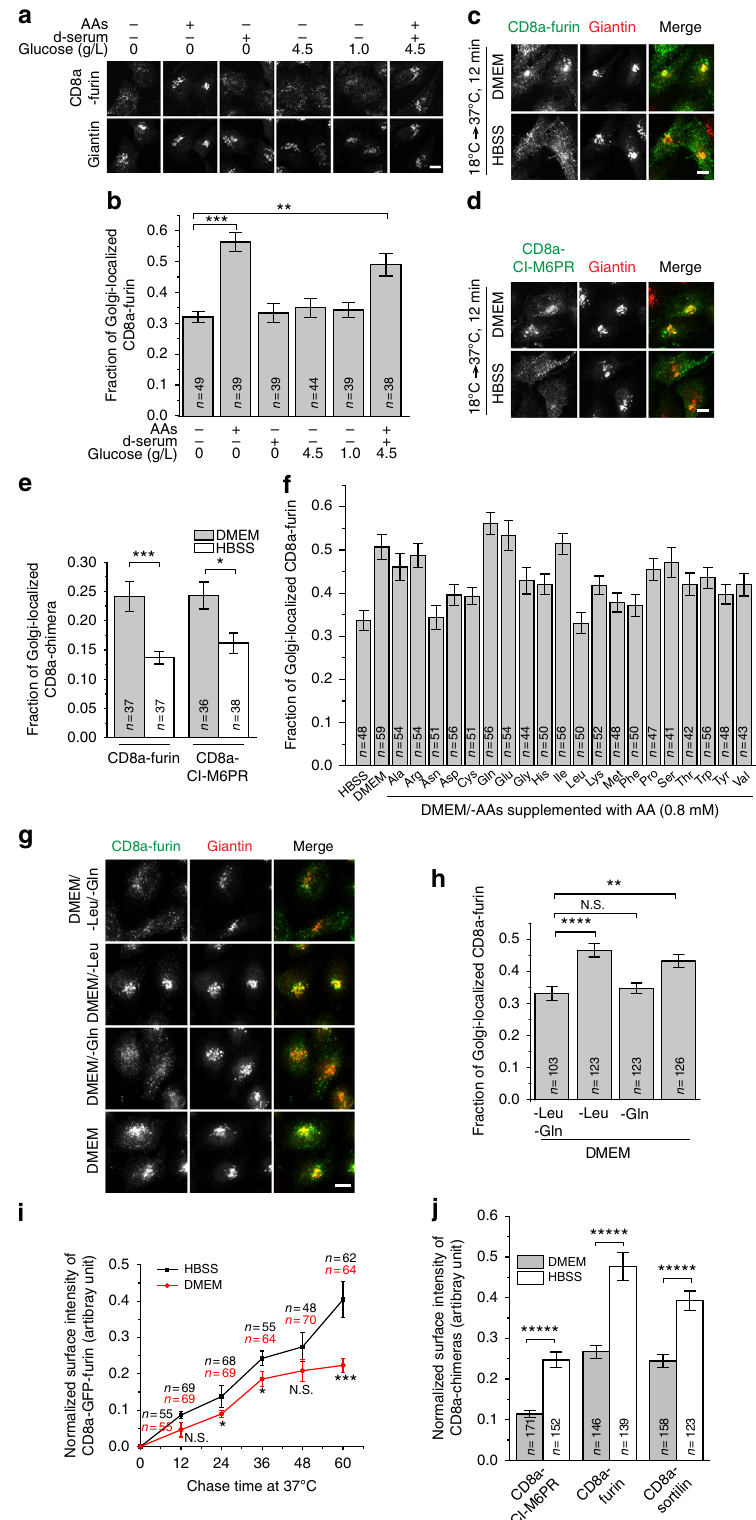
as CD8a-fused CI-M6PR, CD-M6PR and sortilin (Supplementary The endocytic traf fi cking of CD8a-furin to the Golgi comprises Fig. 2a, b) and Shiga toxin B fragment (STxB) (Supplementary two consecutive steps, the clathrin-dependent endocytosis to the Fig. 2c, d); however, the Golgi traf fi cking of Cholera toxin B endosome and the subsequent endosome-to-Golgi traf fi cking. fragment was not signi fi cantly affected by AAs (Supplementary Our quantitative analysis indicated that the internalized CD8a- Fig. 2e, f). furin within 6 min of chase did not display an obvious difference NATURE COMMUNICATIONS| (2018) 9:4987 |DOI: